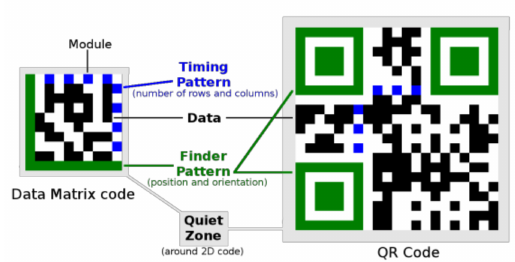
Figure 1. Structure of Data Matrix code compared to QR